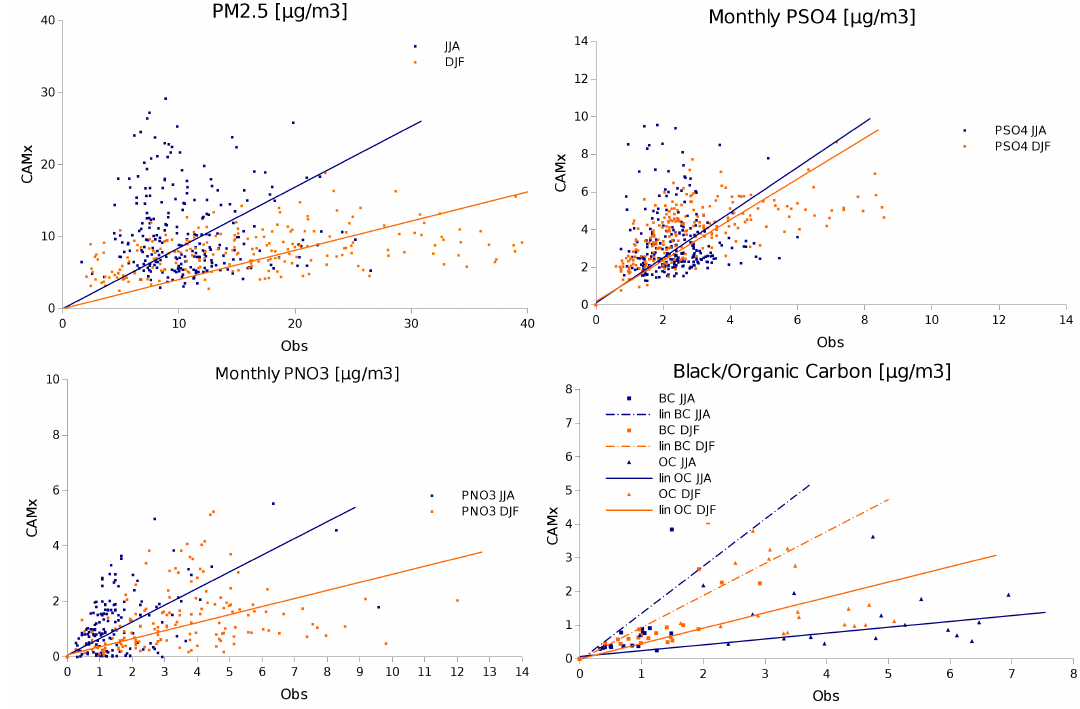
Figure 5. Comparison of monthly values of PM 2 . 5 and its major components (sulfate-, nitrate aerosol, black and organic carbon) for DJF (orange) and JJA (dark blue) months. For carbonaceous aerosol, square stands for BC and triangle for OC. Linear trend lines are also